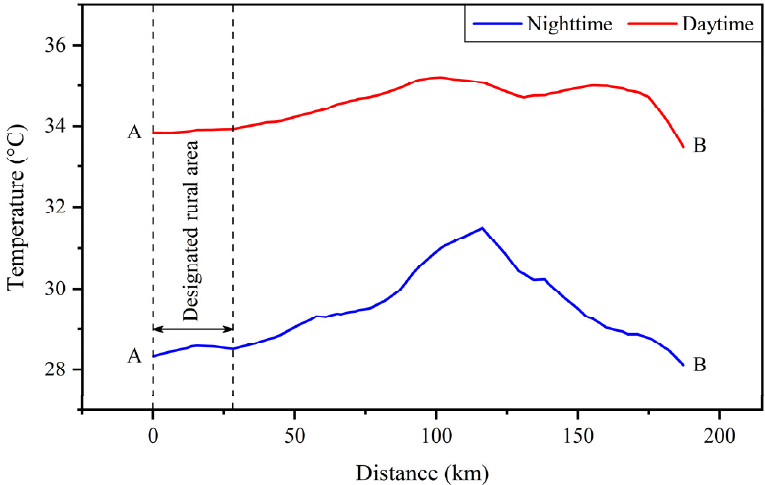
Figure 3. The mean air temperature profiles along line